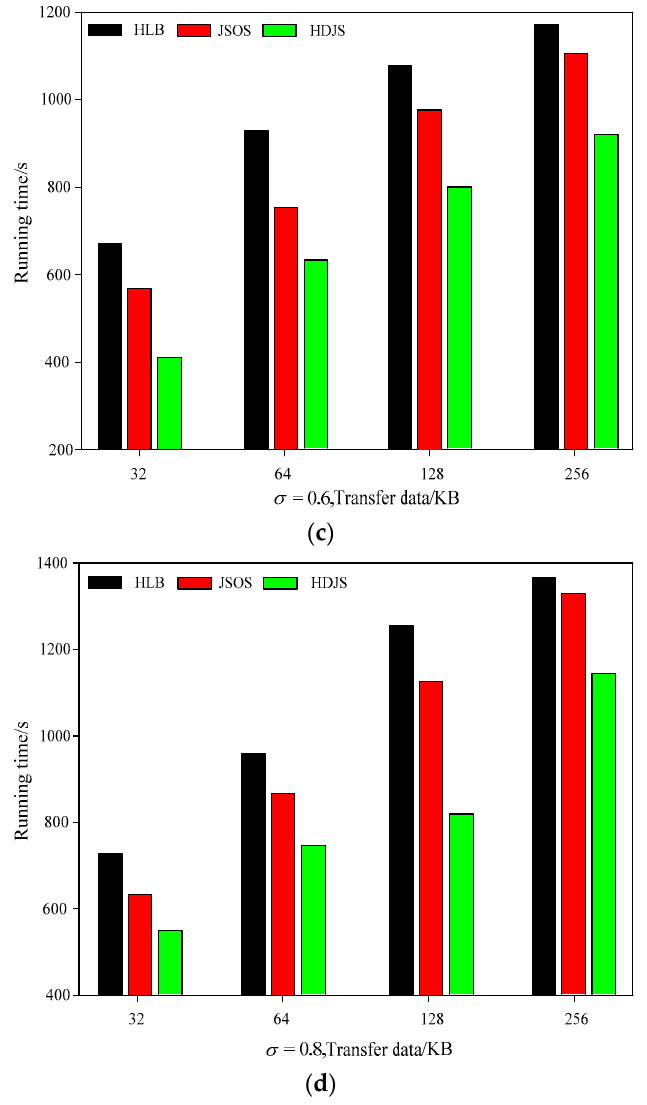
Figure 6. Comparison of data transmission and running time under different parameters; ( a ) σ = 0.2; ( b ) σ = 0.4; ( c ) σ = 0.6; ( d ) σ = 0.8.